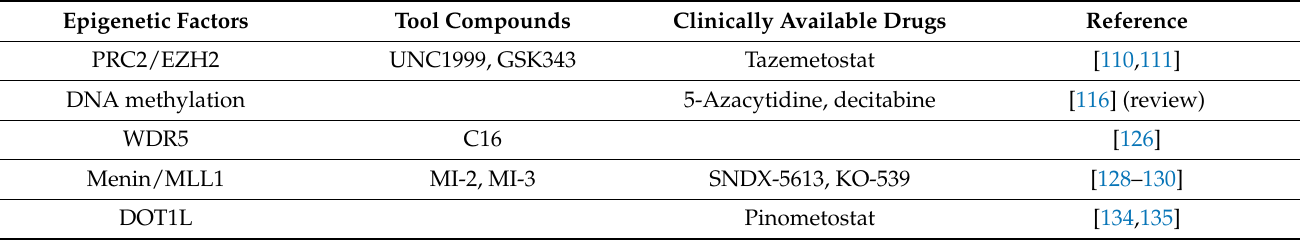
Table 1. Epigenetic factors dysregulated in GBM and compounds targeting